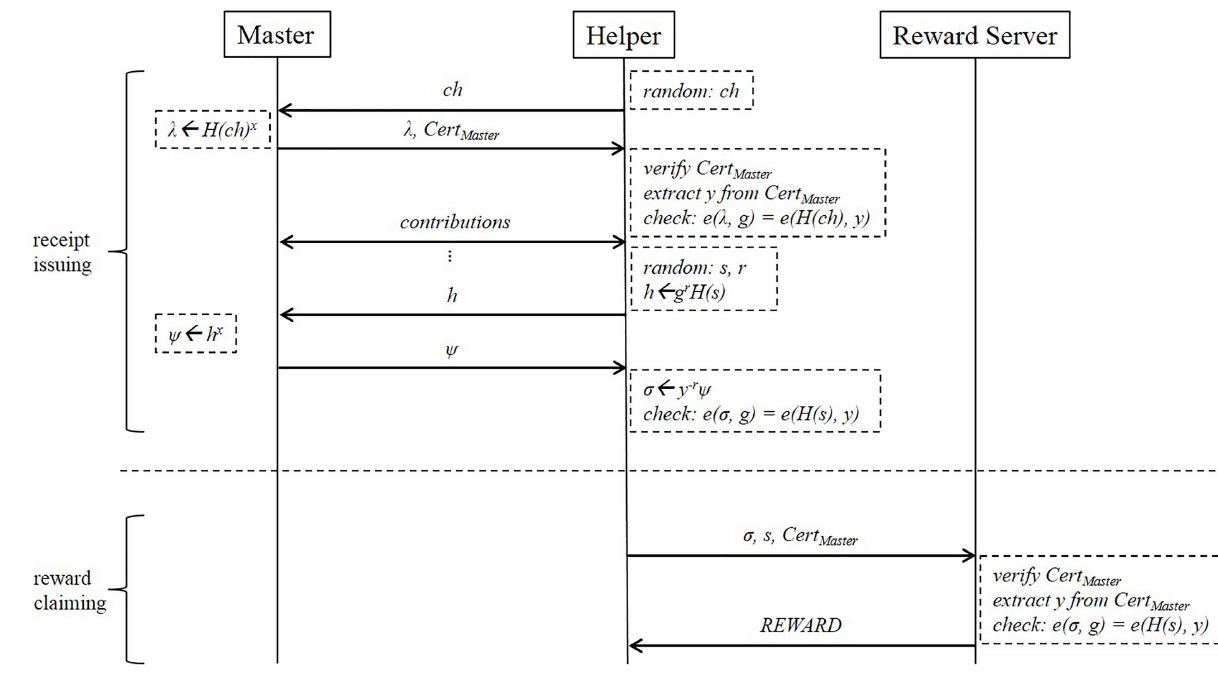
Figure 2. Protocol of reward scheme.